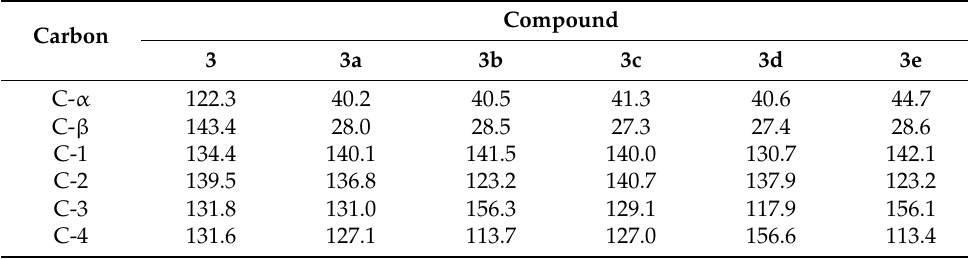
Table 2. 13 C-NMR chemical shifts δ (ppm) and coupling constants J (Hz) of 2 (cid:48)